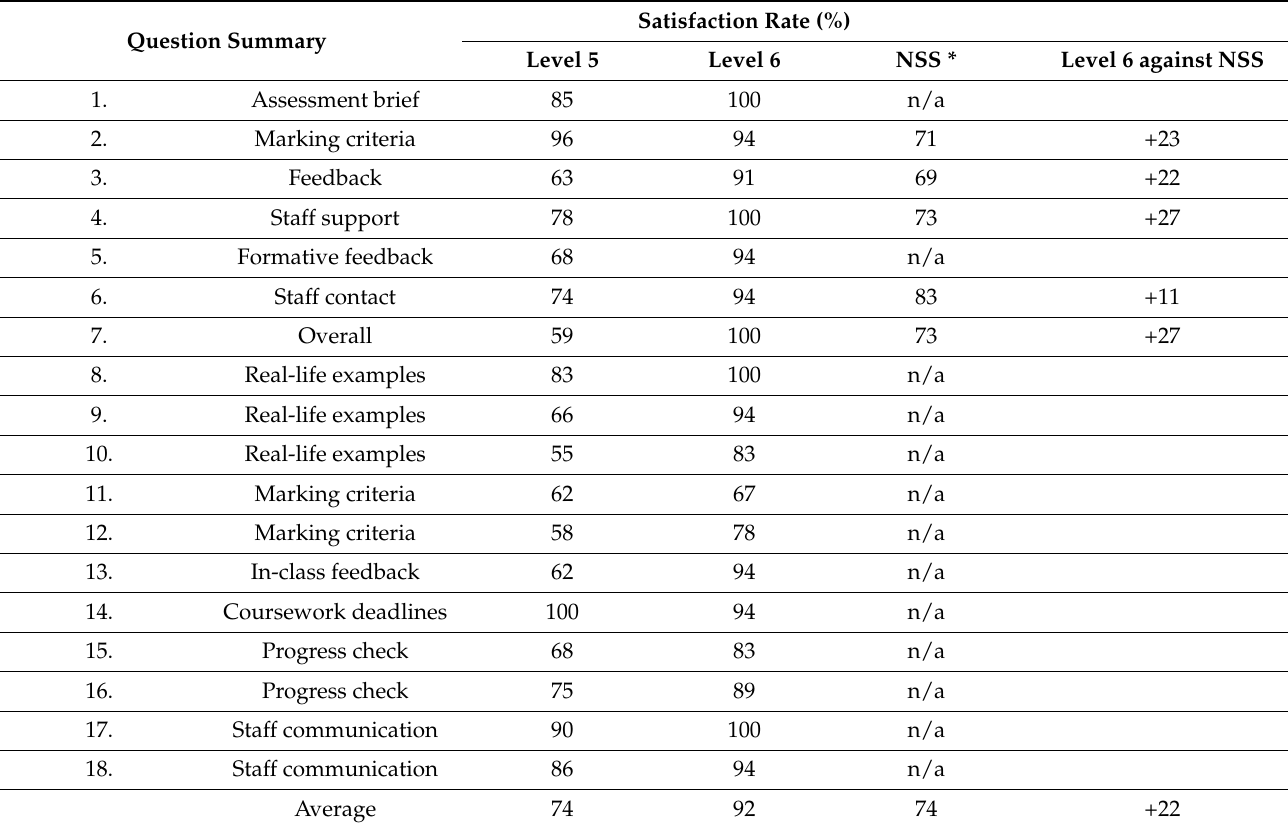
Table 6. End of module survey